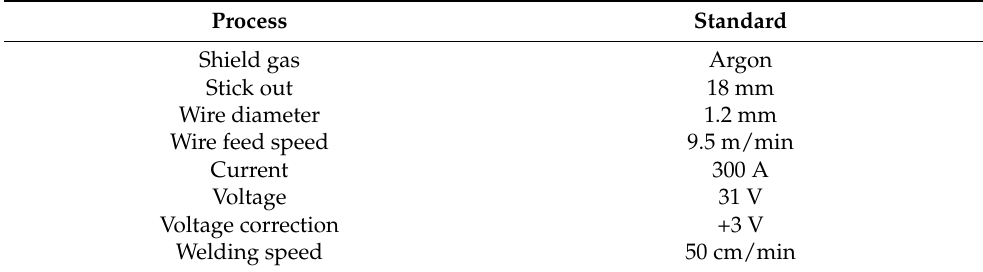
Table 2. Process adjustment